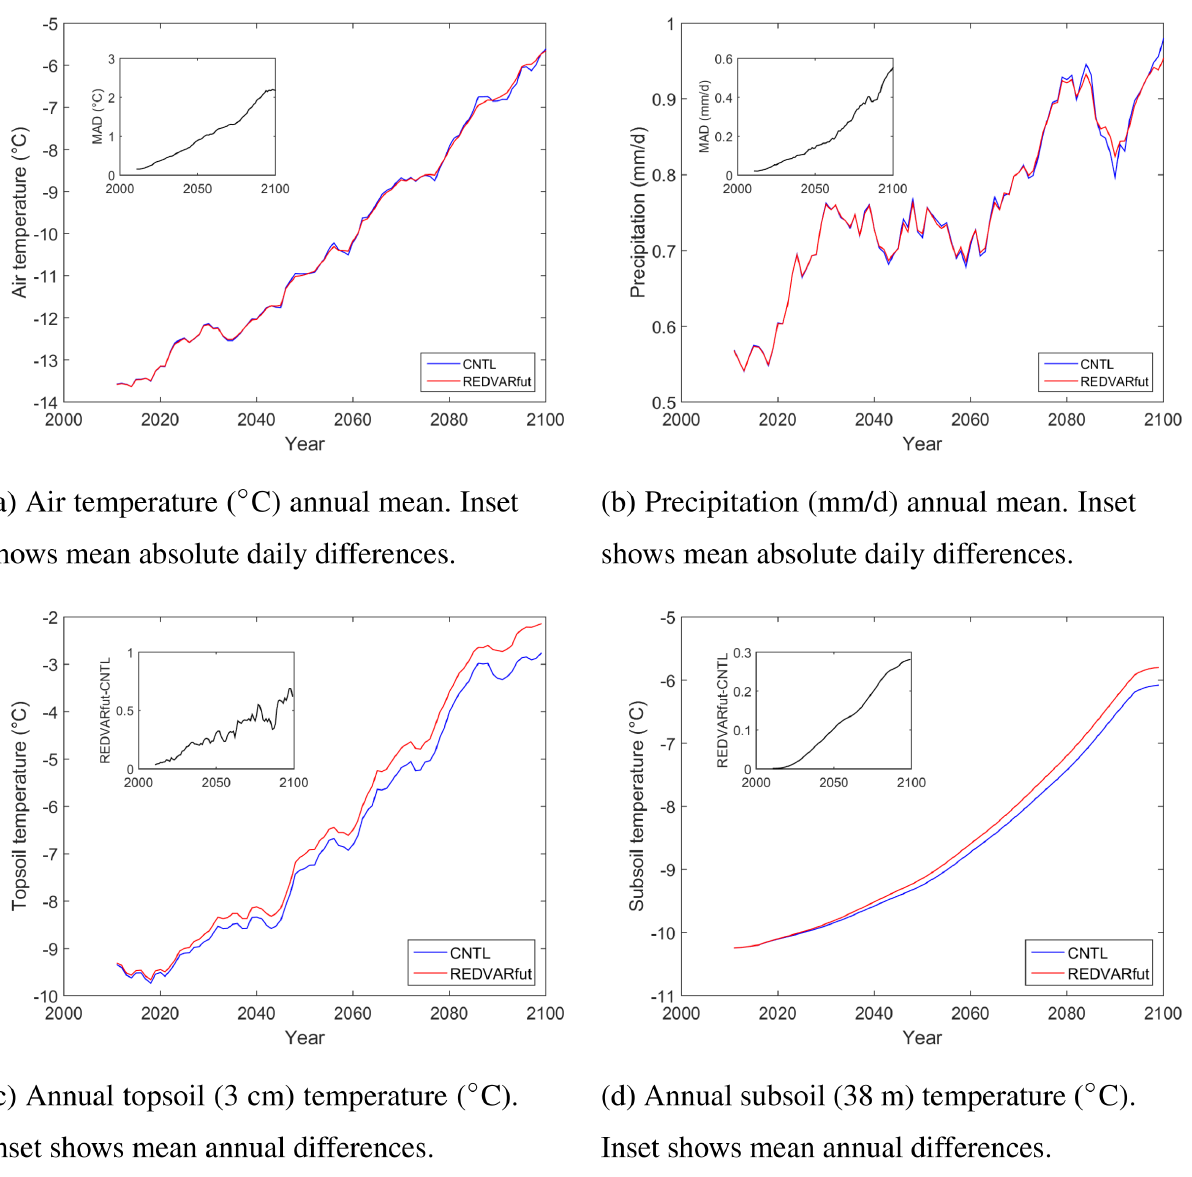
Figure 11. REDVARfut experiment results at a Siberian site (72.2 ◦ N, 147 ◦ E) during 2011–2100 showing the effects of changing climate variability on future soil temperature. Ten-year moving means are